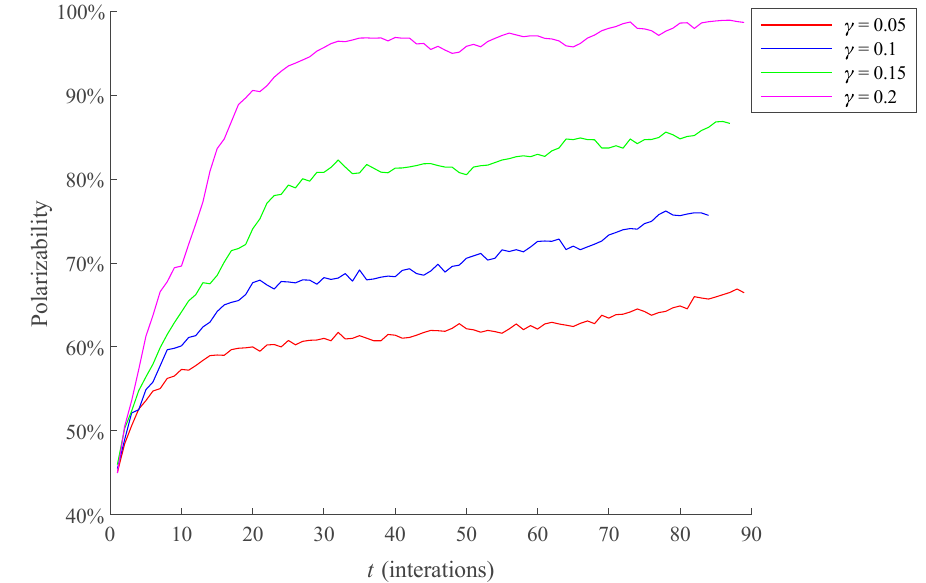
Figure 12. The influence of different γ on the polarization process of public